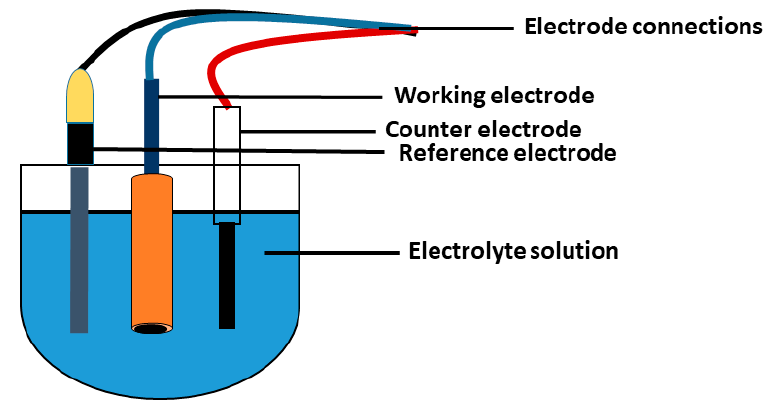
Figure 3. Electrochemical cell .